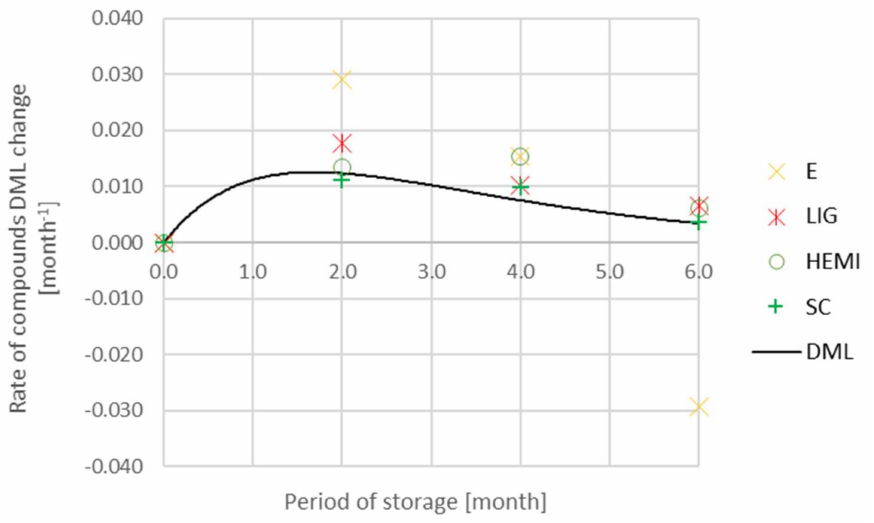
Figure 9. DML and the loss of chemical substances during